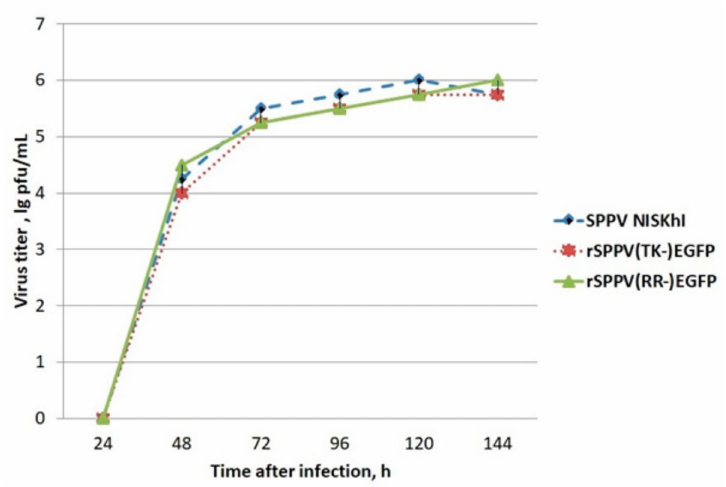
Figure 4. Growth curves for SPPV mutants in LT cells.